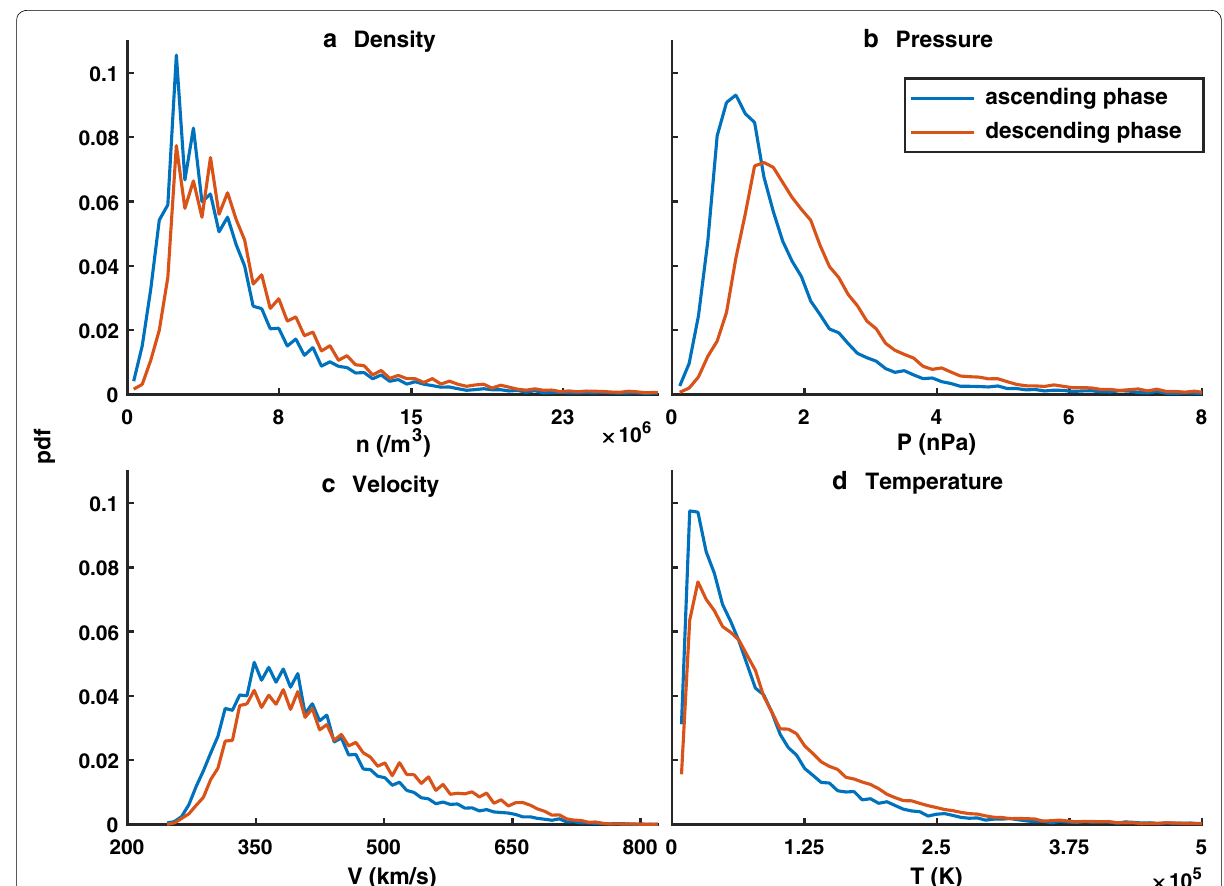
Fig. 8 Probability distribution functions of solar wind parameters: a density n , b dynamic pressure, and c velocity V , and d proton temperature T i at the Earth’s bow-shock nose for the ascending (blue) and descending (red) phases of the solar cycle 24. Here, (cid:31) pdf corresponds to 1, which means